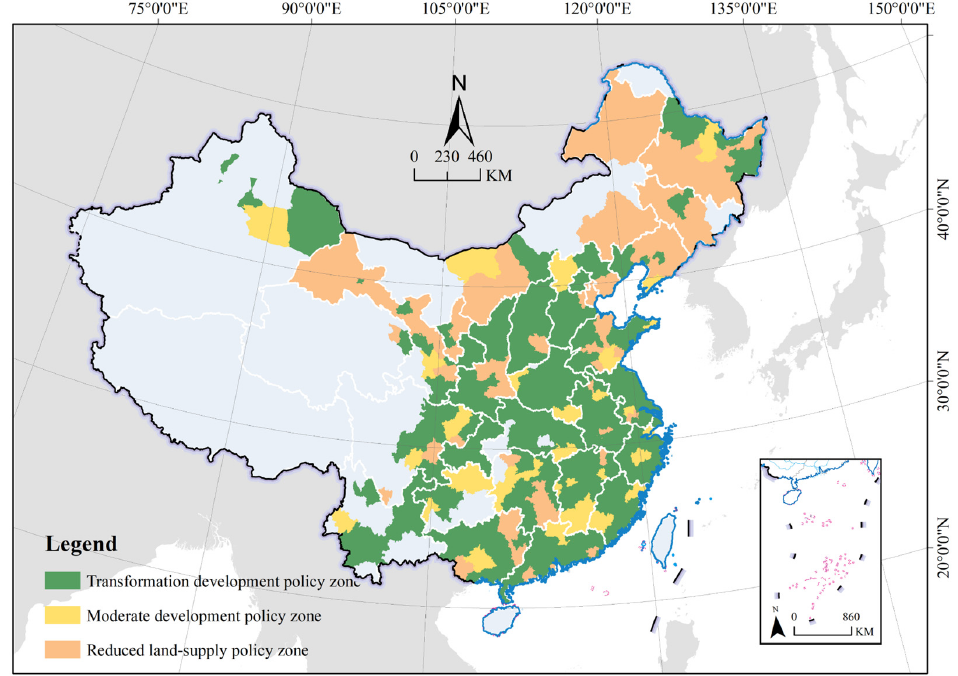
Figure 9. Distribution of policy zones based on INL–SAV and INL–GDP.